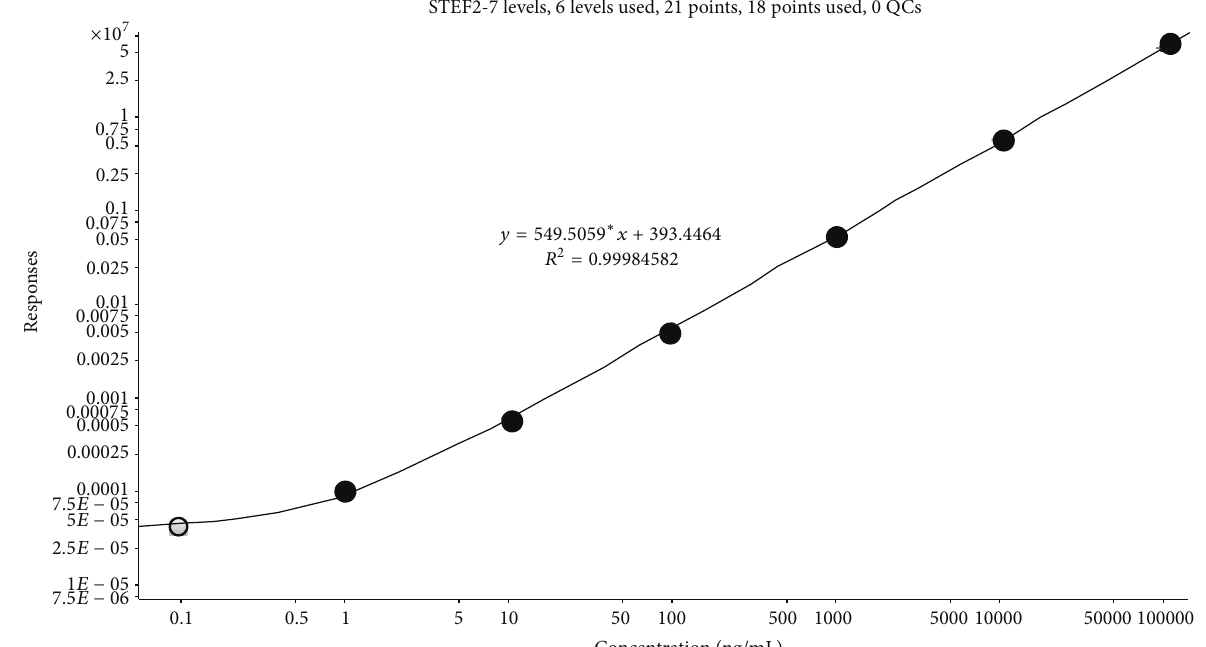
Figure 5: Calibration curve of stepharine plotted in the range of 100 pg/mL to 100 𝜇 g/mL. Calibration curve was weighted with 1/𝑥 factor and the correlation coefficient made 𝑟 2 > 0.99 . Each data point averaged on three replicates. Table 2: Concentration of stepharine in rabbit plasma after intramuscular administration ∗ . Time